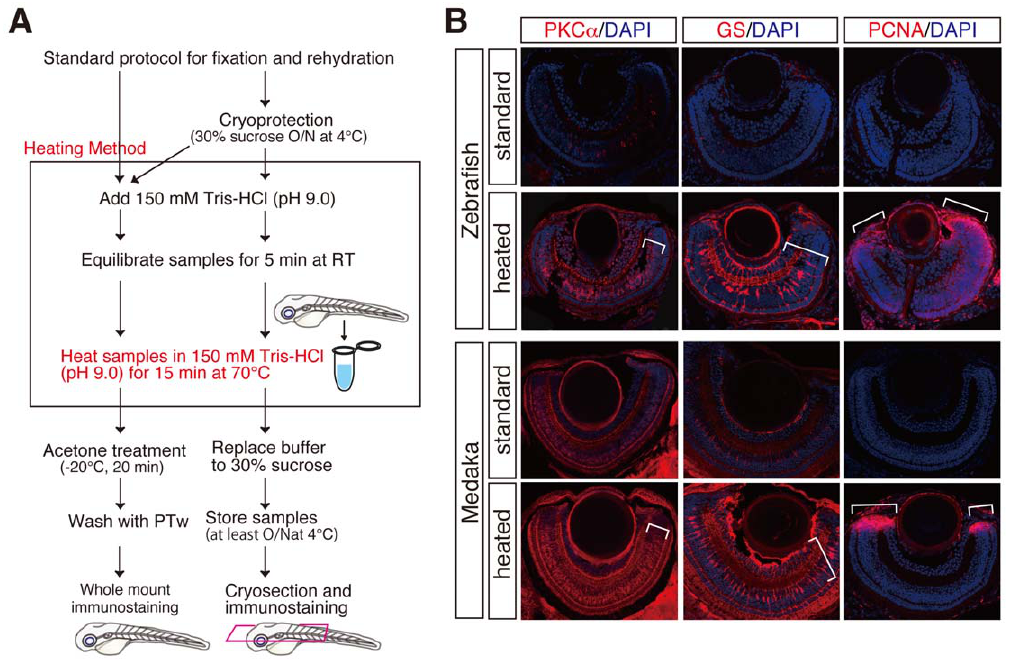
Figure 1. Improvement of fluorescent immunostainings by a novel heating method. ( A ) Schematic flowchart including a novel heating step in the standard immunostaining for cryosections and whole mount preparations. Whole mount and cryoprotected fish embryos were heated at 70 u C for 15 min in 150 mM Tris-HCl at pH 9.0 (framed), subjected to the respective standard protocol for immunostaining. Cryoprotected preparations also can be used for whole mount immunostaining (bifurcated arrows). ( B ) Fluorescent immunostainings with cryosections of zebrafish and medaka retinae using anti-PKC a , anti-GS and, anti-PCNA antibodies. PKC a , GS, and PCNA immunostainings mark bipolar, Mueller glia, and retinal progenitor cells, respectively. Note that the heating method (heated) but not standard method (standard) efficiently improved all the immunostainings (lower panels, see brackets). Nuclei were counterstained with DAPI (blue).